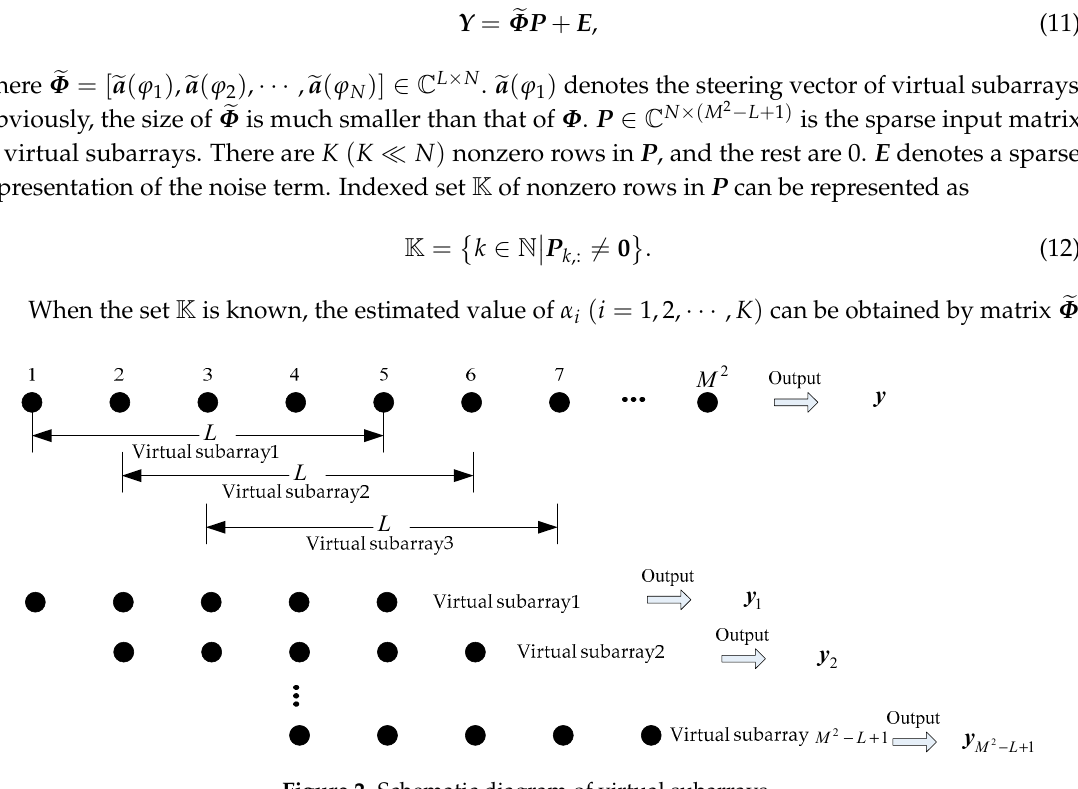
Figure 2. Schematic diagram of virtual subarrays.